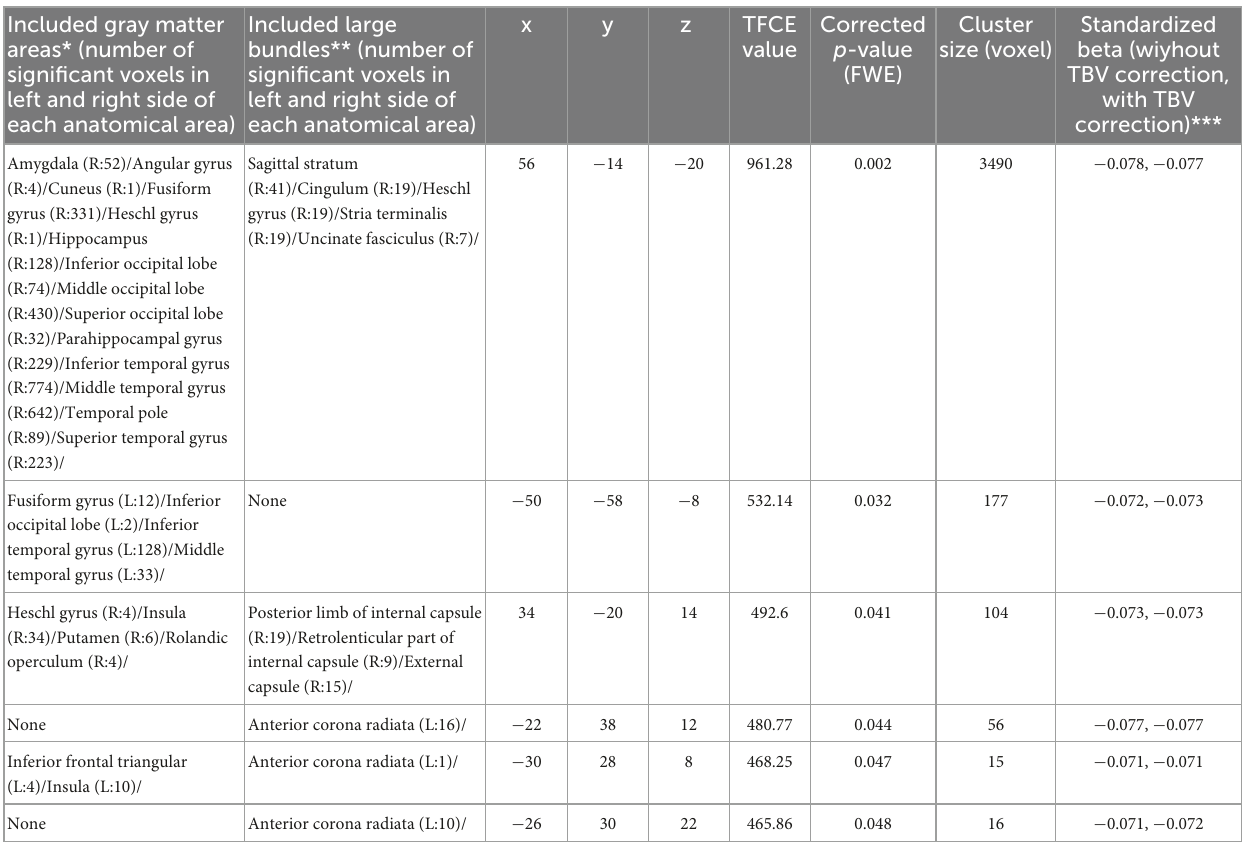
*Labelings of the anatomical regions of gray matter were based on the WFU PickAtlas Tool (https://www.nitrc.org/projects/wfu_pickatlas/) (Maldjian et al., 2003, 2004) and on the PickAtlas automatedanatomicallabelingatlasoption(Tzourio-Mazoyeretal.,2002).Temporalpoleareasincludedallsubregionsintheareasofthisatlas. **The anatomical labels and significant clusters of major white matter fibers were determined using the ICBM DTI-81 Atlas (http://www.bmap.ucla.edu/portfolio/atlases/ICBM_DTI-81_